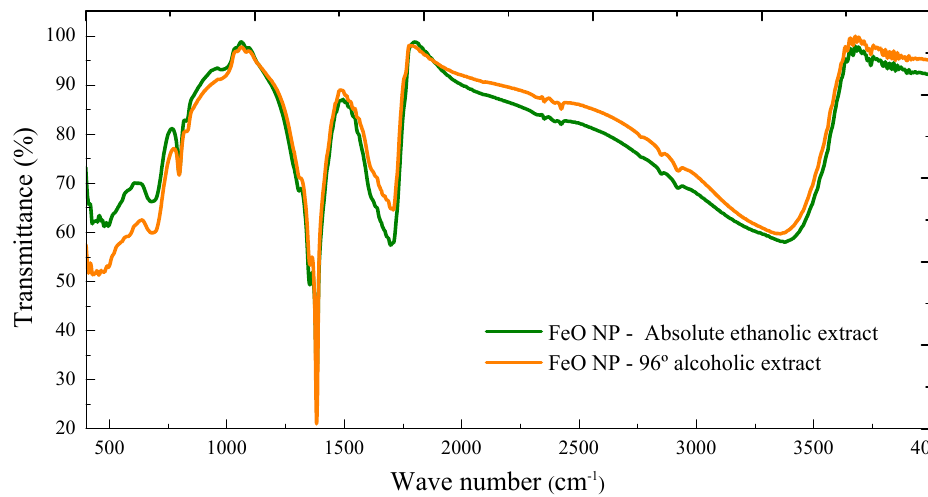
Figure 4. FTIR spectra of FeO NP using 96% alcohol solvent extract and absolute ethanol.